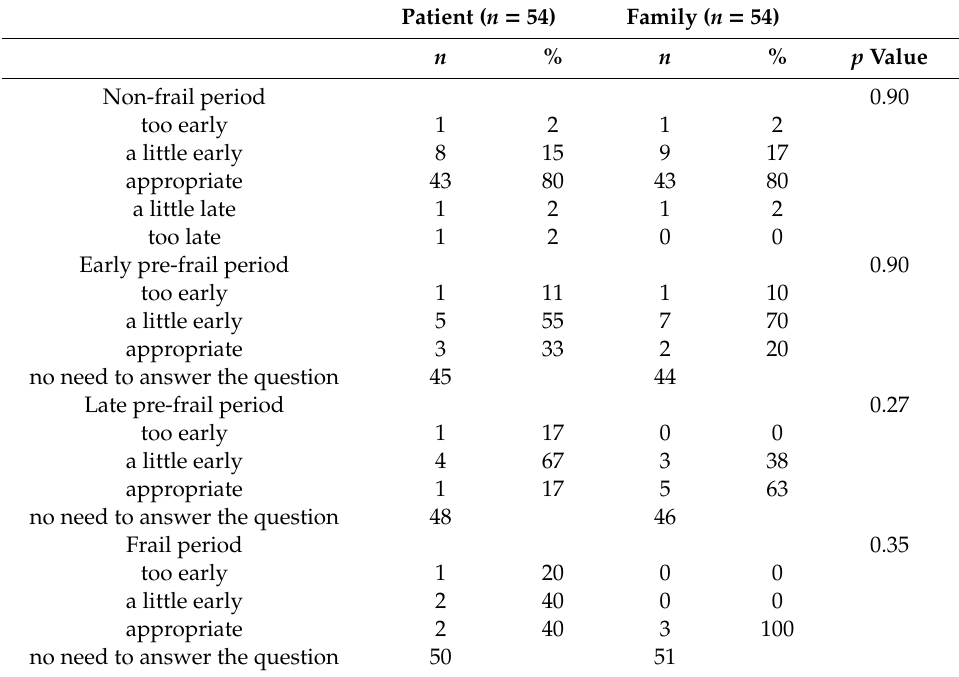
Table 2. Comparison of preferred timing of initiating advance care planning between patients and family caregivers.